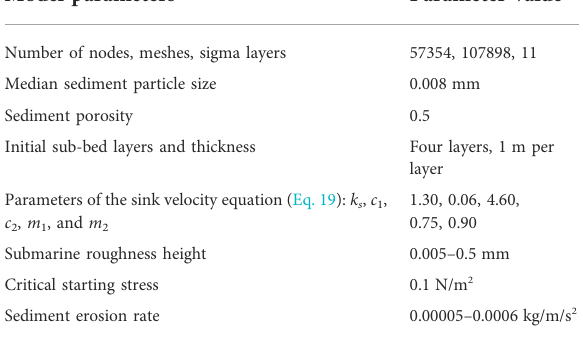
TABLE 1 Main parameters of the